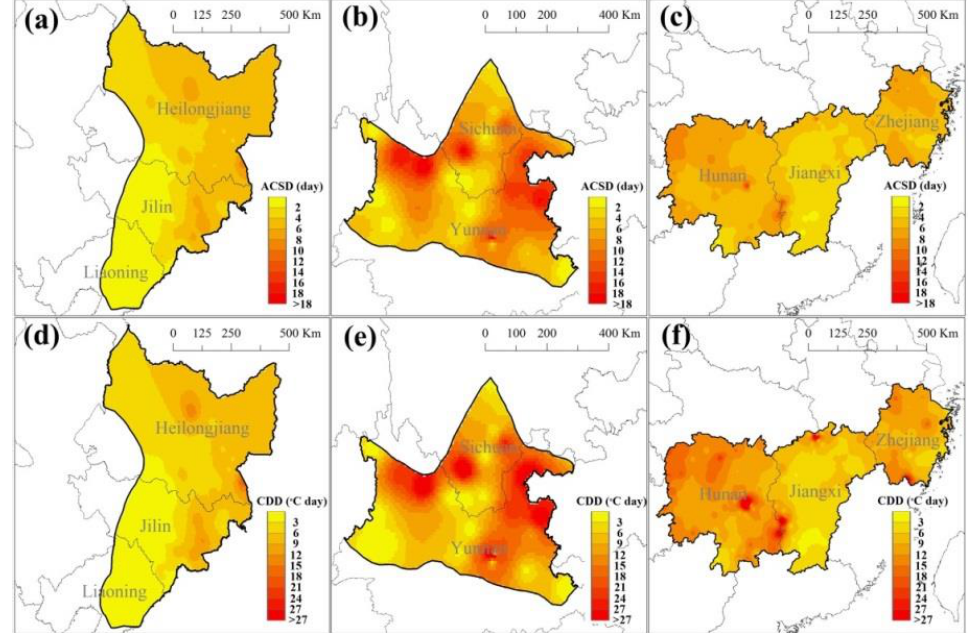
Figure 2. Spatial variation of average values of cold stress indices during heading and flowering during 1960 – 2019 across three ecoregions of China: ( a , d ) single rice in NEP; ( b , e ) single rice in YNP; ( c , f ) late rice in SMLYR. ACSD, accumulated cold stress days; CDD, cold degree days.